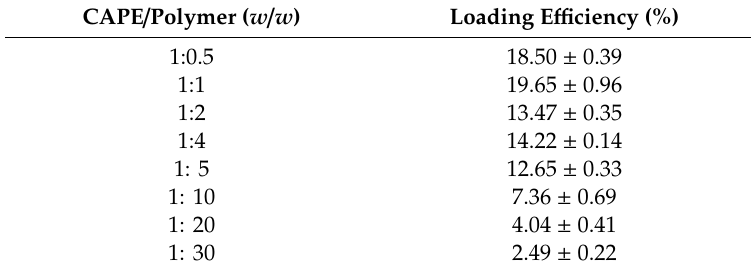
Table 2. Loading e ffi ciency of CAPE-MotAb prepared with di ff erent weight ratios of CAPE powder and DPSE-PEG-NHS Table 2. Loading efficiency of CAPE-MotAb prepared with different weight ratios of CAPE powder and DPSE-PEG-NHS polymers.